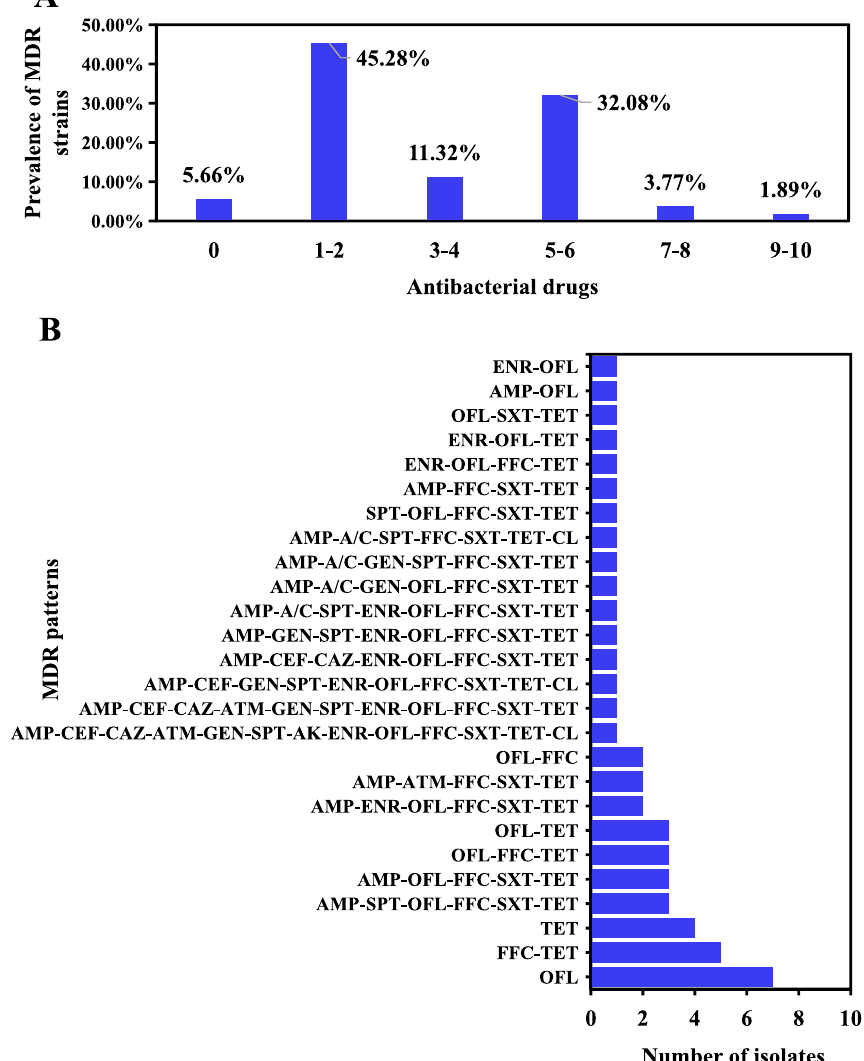
Fig. 3 Prevalence ( A ) and patterns ( B ) of multi-drug resistance of 53 Salmonella strains isolated from the chicken production chain in Hubei Province,